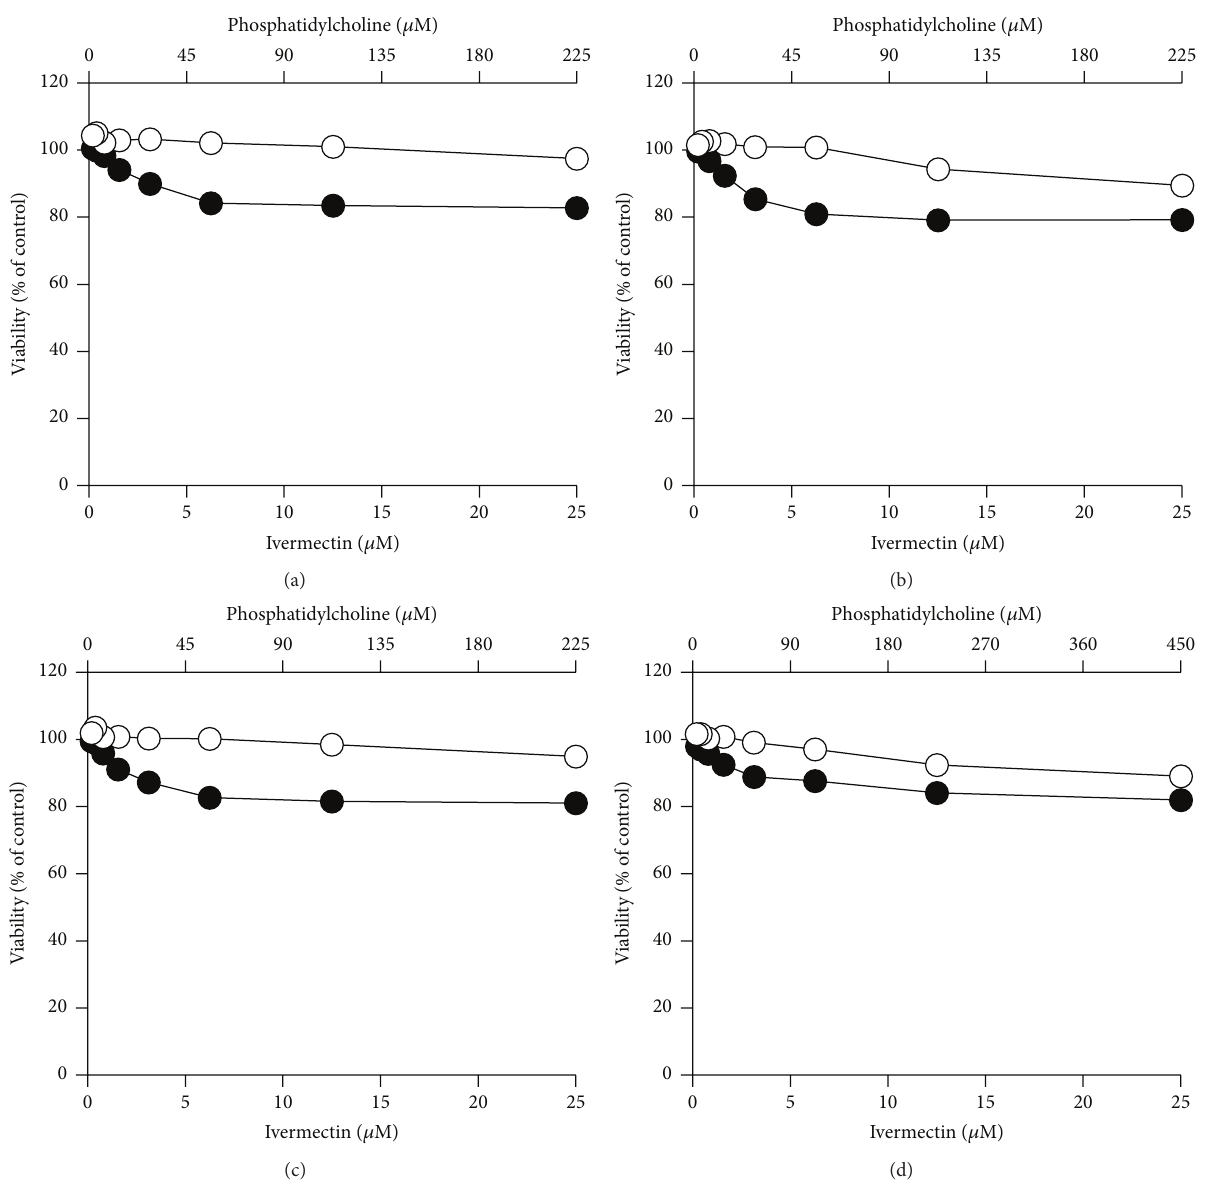
Figure 8: In vitro cytotoxicity effect of ivermectin formulated in liposomes (closed circles) on Vero-118 cells. For comparison the same experiments were performed using empty liposomal formulations (open circles). The following liposomal formulations were tested: #PC9- Ch1 and #PC9-Ch1-ive1.0 (a), #PC9-Br1 and #PC9-Br1-ive1.0 (b), #PC9-Br0.5 and #PC9-Br0.5-ive1.0 (c), and #PC18-Br1 and #PC18-Br1-ive1.0 (d). The phosphatidylcholine concentration (top 𝑥 -axis) is related to empty liposomes while the ivermectin concentration (bottom 𝑥 -axis) is related to ivermectin liposomes. Details on the identification codes and liposomal compositions are included in Table 1. Data represent the average of 2